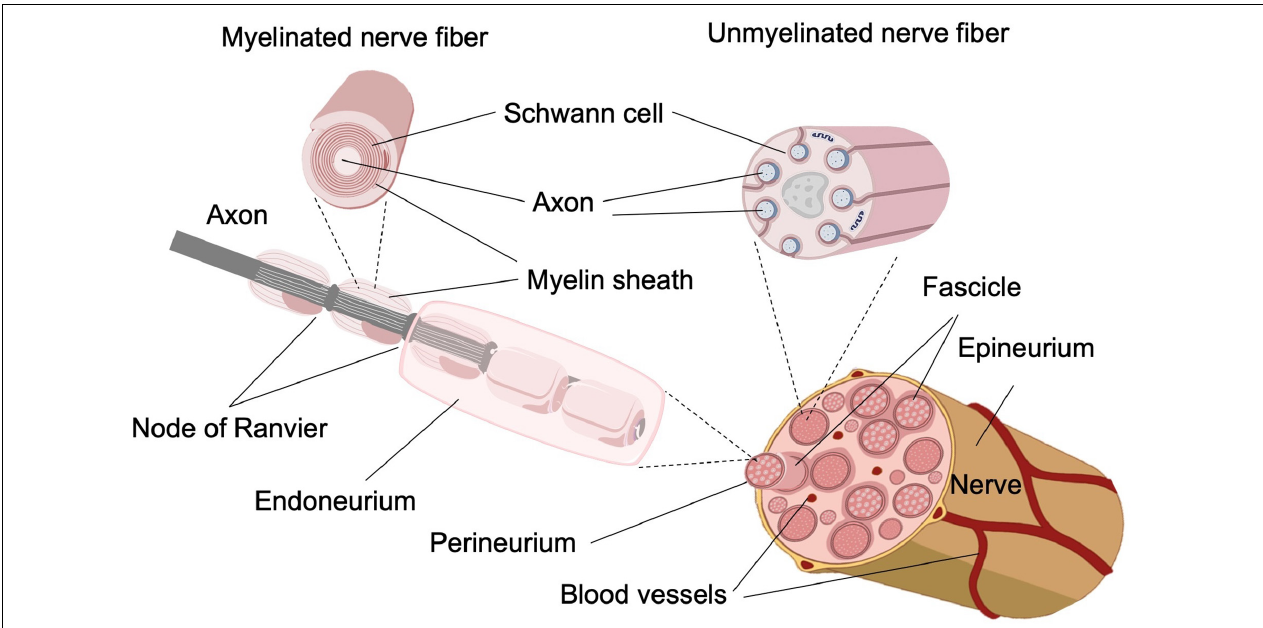
FIGURE 1 | Representative structure of a peripheral nerve. (Top) Representation of the functional unit made up of axons wrapped by the Schwann cell. The representation of myelinated and unmyelinated fibers and their differences by the presence of myelin and by the number of axons involved by each Schwann cell can be observed. (Bottom) In the peripheral nervous system, each nerve fiber is surrounded by a Schwann cell and the endoneurium individually, consisting of loose connective tissue. In turn, the individual neurons are grouped into bundles, called fascicles, and each of these is surrounded by the perineurium. The epineurium, the outermost layer, is going to be in charge of protecting and unifying the nerve. Finally, we find the presence of the vasa